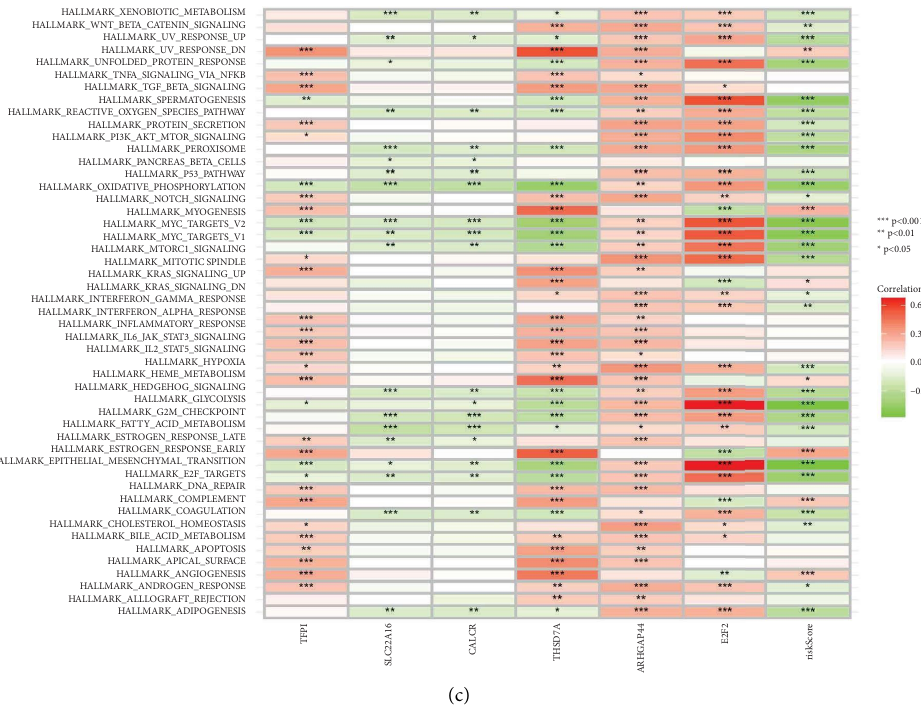
Figure 9: (a) Te GSEA analysis based on E2F2; (b) the GSEA analysis based on THSD7A; (c) the GSVA analysis based on the risk score and key genes involved in GC